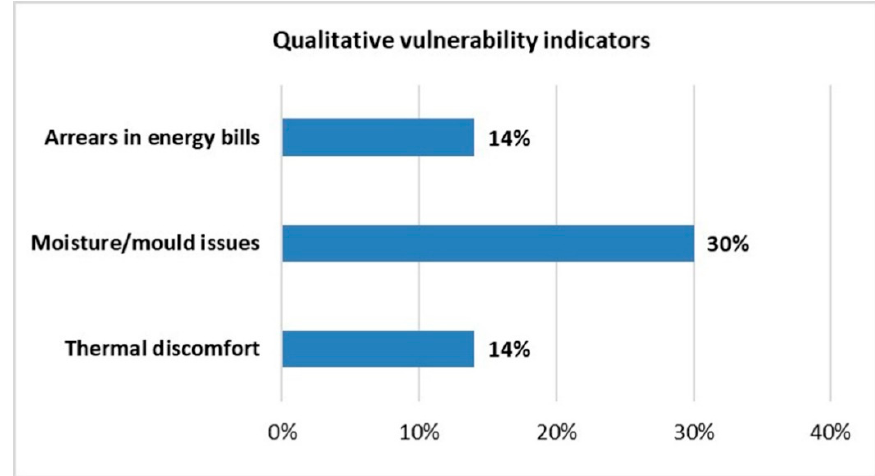
Figure 3. Qualitative indicators of energy